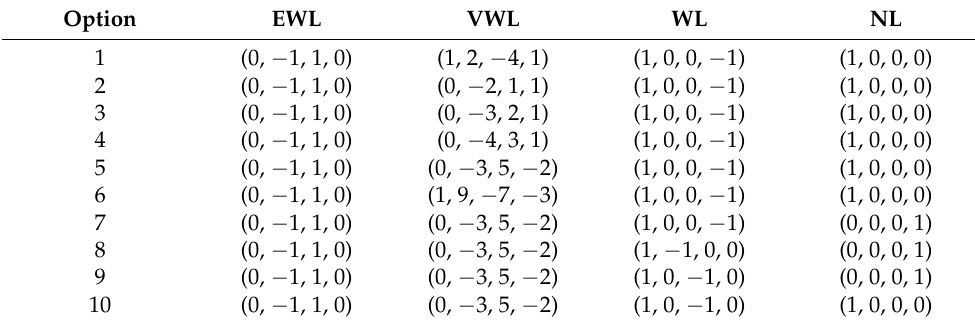
Table 5. A list of different options for the Galileo QCAR method.